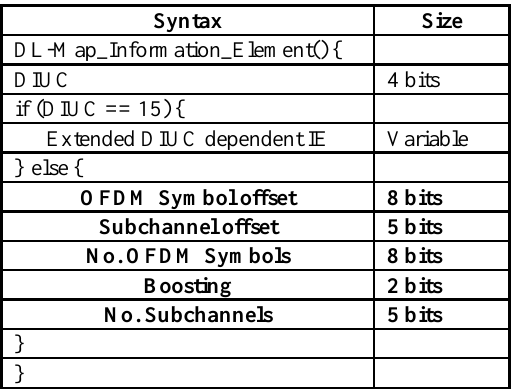
Table 1. Uplink MAP Header Information Element